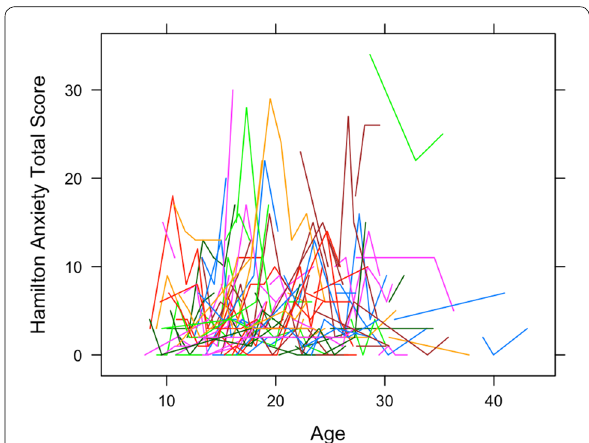
Fig. 1 Hamilton anxiety scores plotted against age of assessment. Each line represents a unique individual (n